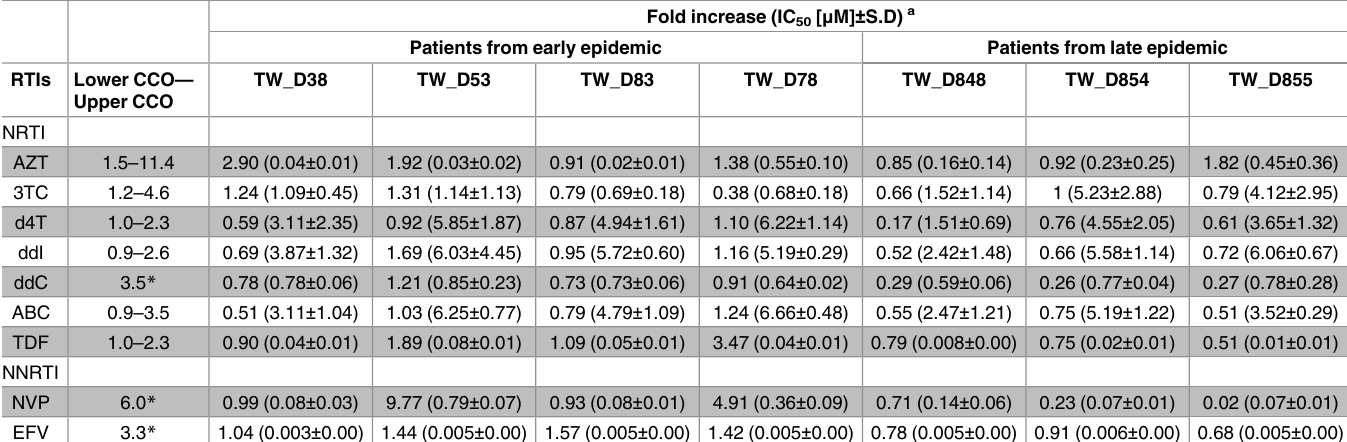
Table 3. Fold increaseof IC 50 of Taiwanese CRF07_BCfor various reverse transcriptase